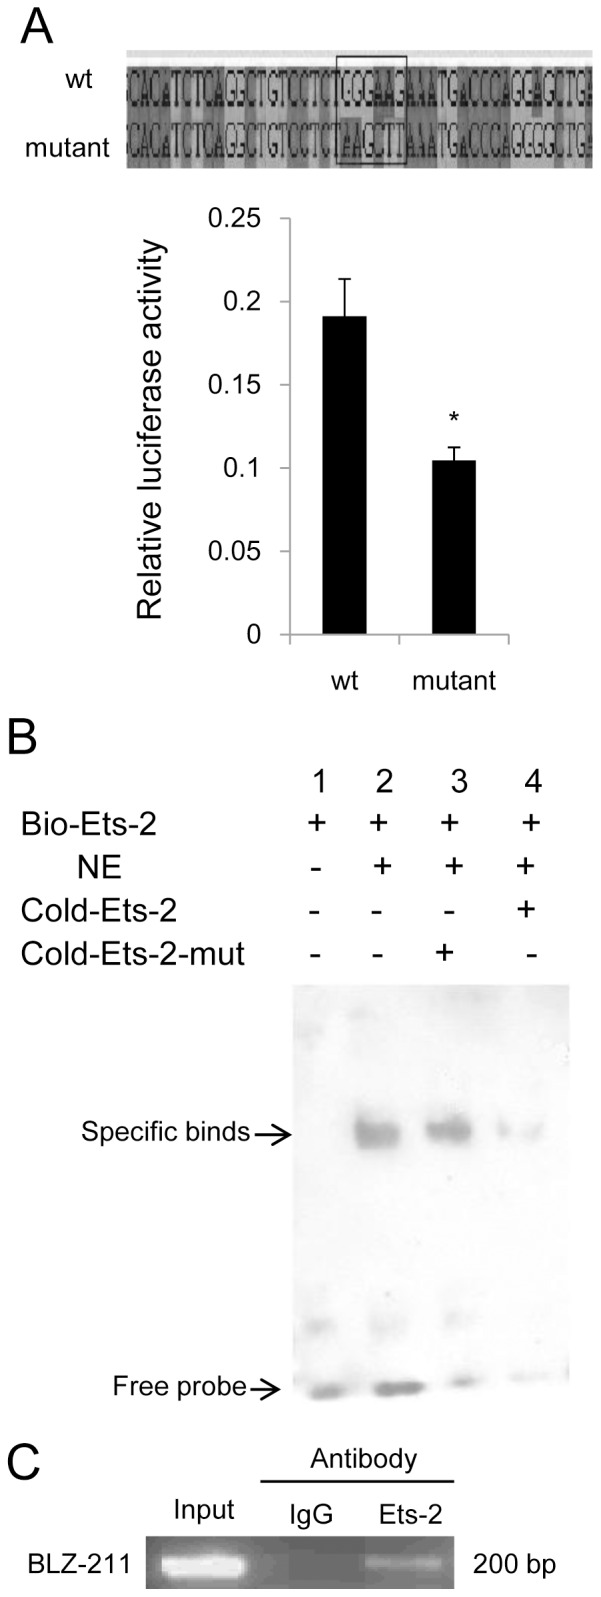
Ets-2-binding sites contribute to promoter activation of the UCA1.(A) Luciferase assay. The Ets-2 binding sites (GGGAAG) were replaced with HindIII sites (AAGCTT) by site-directed mutagenesis (upper panel). Relative luciferase activities of the wild-type (wt) and the mutant vectors (mutant) were measured by luciferase assay. Values represent means ± SD of at least three independent experiments. *P<0.05. (B) In vitro detection of Ets-2 transcription factor binding to the promoter region of the UCA1 gene by EMSA assay. One predominant band was observed when biotin-labeled Ets-2 probe was incubated with the nuclear extract (lane 2). Ets-2 binding could not be inhibited by the mutant probe (lane 3) while it was competed with the unlabeled cold probe (lane 4). (C) In vivo detection of Ets-2 transcription factor binding to the promoter region of the UCA1 gene promoter by ChIP assay. Input chromatin (Input), which represented portions of sonicated chromatin before immunoprecipitation, was used as a positive control. IgG antibody was used as a negtive control of ChIP assay.